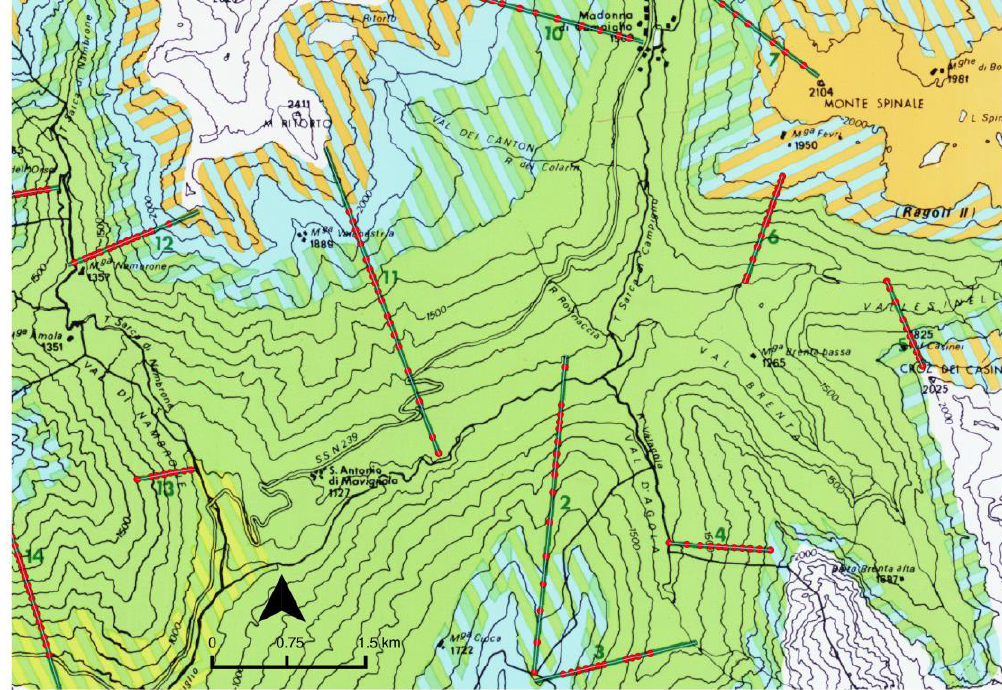
Figure 3. Particular of the historical map overlaid with the sampling points recovered and georeferenced in this work.